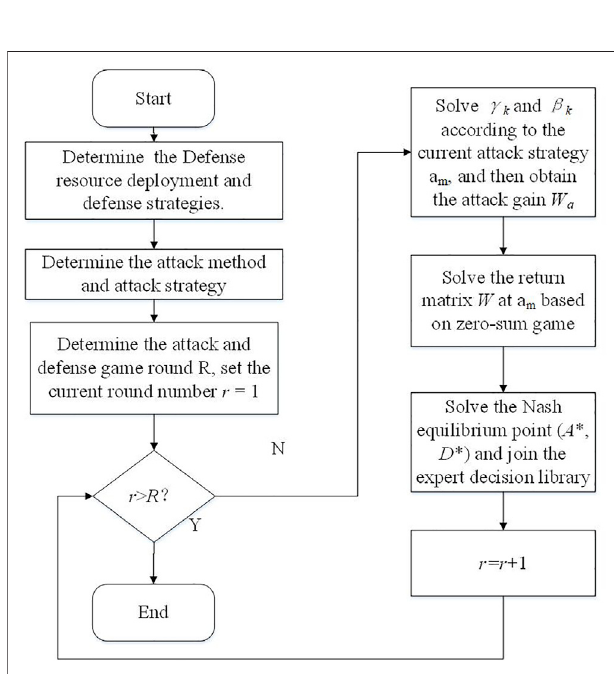
FIGURE 6 | The attack and defensive strategies fl ow